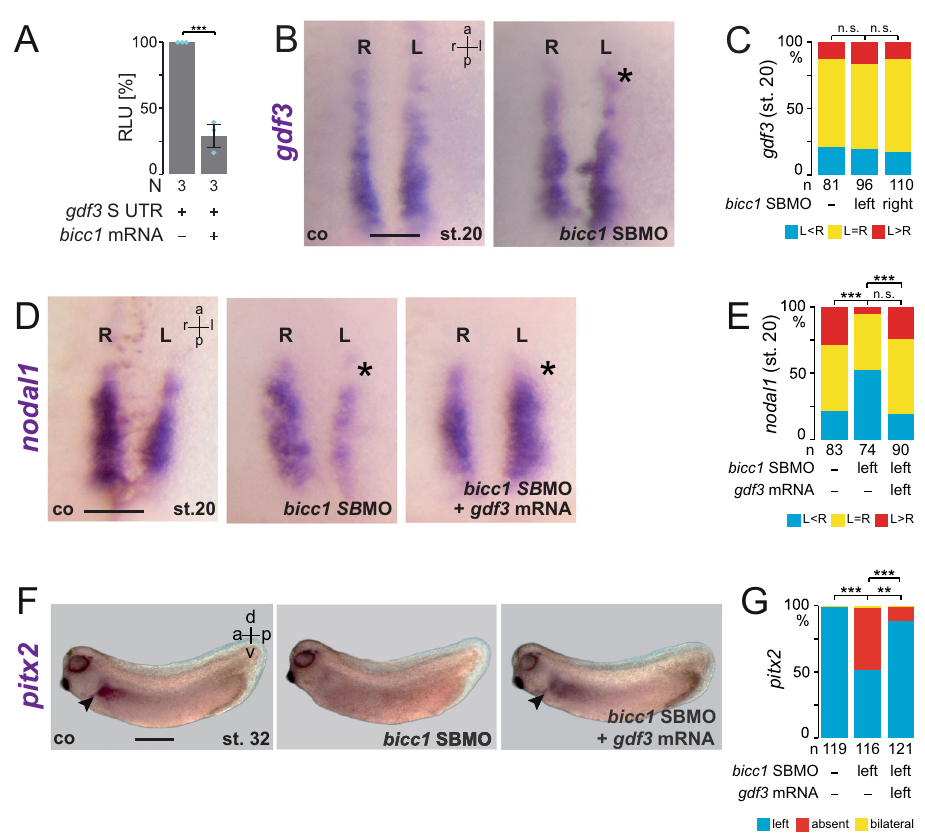
Fig. 4 Bicc1 indirectly regulates nodal1 expression via Gdf3 signaling. A Animal cap assay using a luciferase reporter mRNA which contained gdf3 3 ′ -UTR sequences. Translation of gdf3 reporter was ef fi ciently blocked by co-injecting bicc1 mRNA. N represents the number of independent experiments. A pool of 10 animal caps was analyzed per experiment and treatment. The result from reporter mRNA alone served as a reference and was set to 100% RLU. Relative values of single experiments are depicted as blue dots. Data of three experiments are presented as mean value (bar) ±standard deviation (error bar, SD). Statistical analyses were done with a one-sided Student ’ s t test for two independent means using the values of three individual experiments. B gdf3 mRNA was not affected by bicc1 LoF. C Quanti fi cation of gdf3 expression in bicc1 morphants at the LRO margin. D gdf3 GoF rescues nodal1 expression in bicc1 morphants. Representative nodal1 staining in left sLRO cells is shown for control (co), bicc1 morphant, and rescued specimens. E Quanti fi cation of the bicc1 MO rescue of nodal1 expression by gdf3 . F , G Left-asymmetric pitx2 expression (arrowhead) is restored in bicc1 morphants by co-injecting gdf3 mRNA. MO pmol/embryo: bicc1 SBMO (L and S, each 1). Asterisks in B and D mark injected side. Numbers (n) in C , E , and G represent analyzed specimens from more than independent experiments. Statistical analyses were done with one-sided Pearson ’ s chi-square test, which was adjusted for multiple comparisons